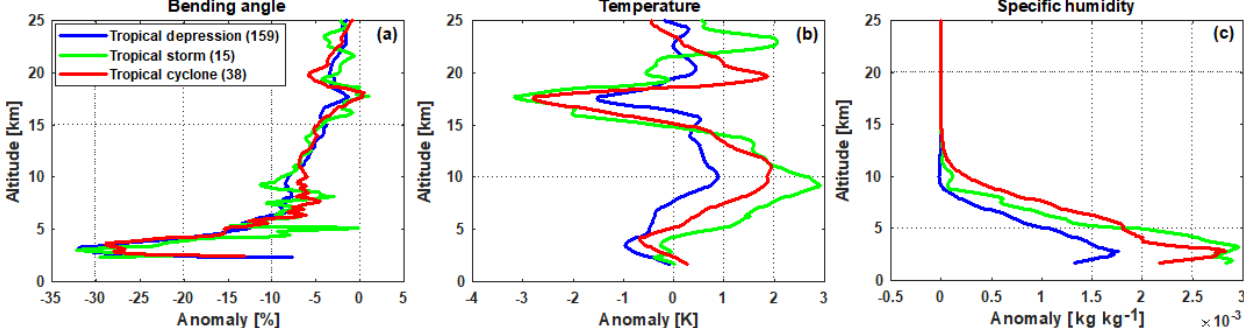
Figure 5. Averaged bending angle anomaly (a) , temperature anomaly (b) and specific humidity anomaly (c) profiles for the TD, TS and TC status of Hondo